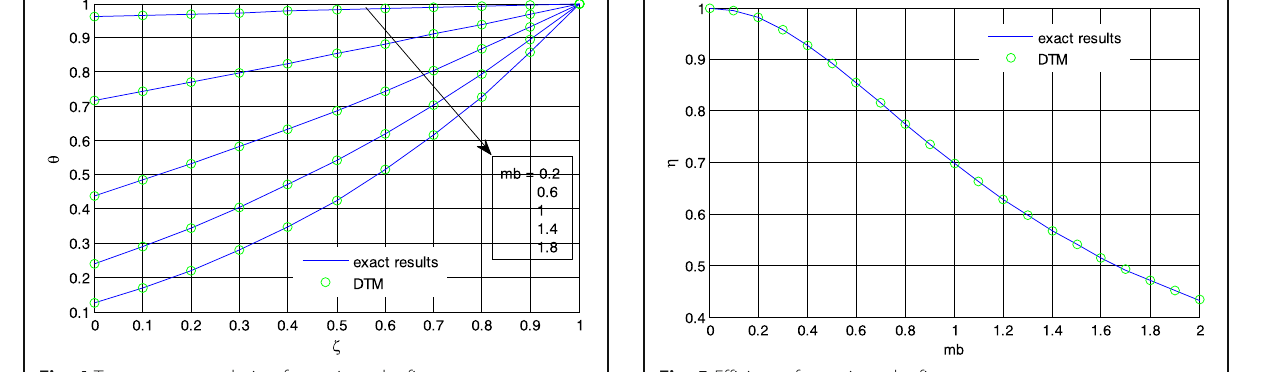
Fig. 4 Temperature evolution for a triangular fin Fig. 5 Efficiency for a triangular